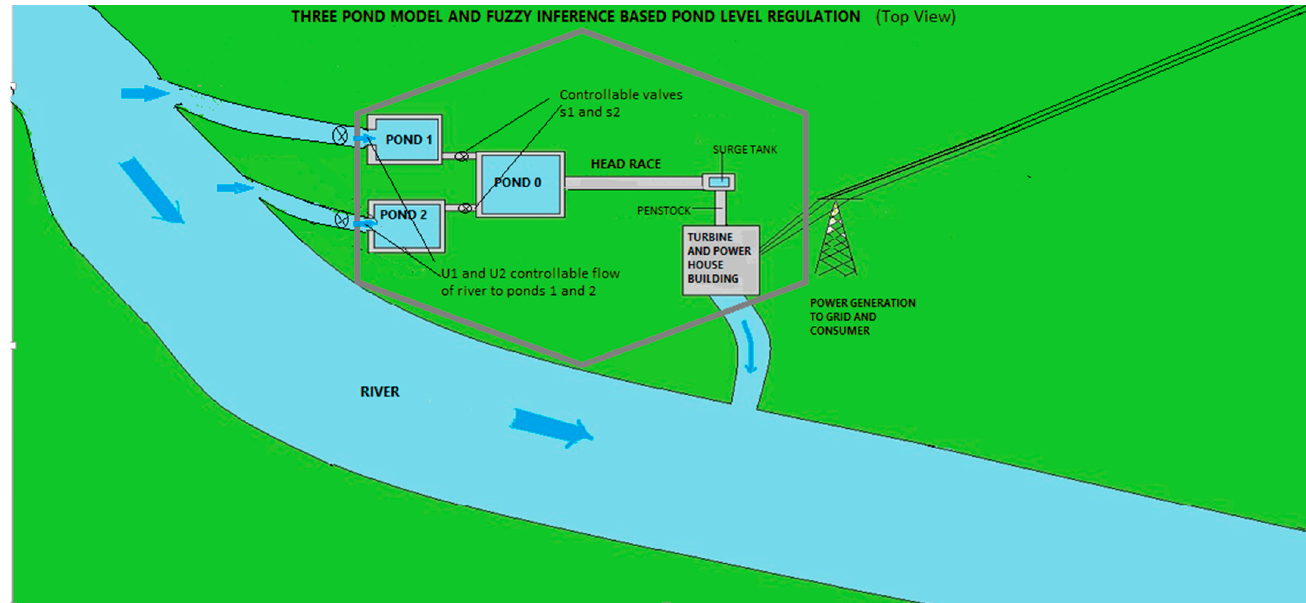
Figure 1. Proposed Three-Pond run-of-river hydropower plant.